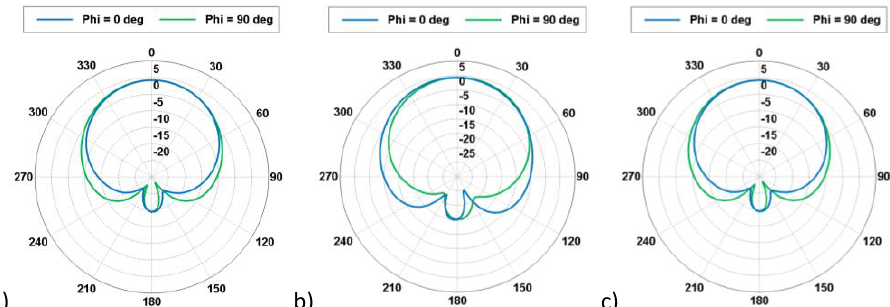
Fig. 2. 3D radiation pattern of a single radiator at a frequency 5 GHz.